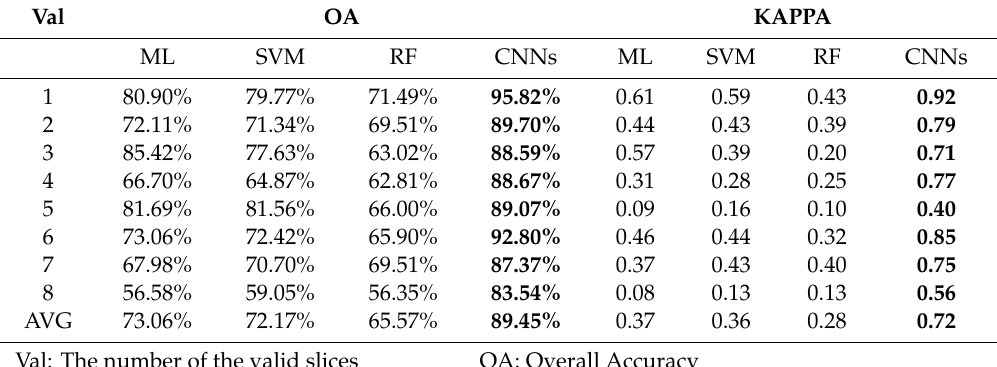
Table 5. Comparisons of Maximum Likelihood (ML), Support Vector Machine (SVM), Random Forest (RF), and Convolutional Neural Networks (CNNs) on pixel-wise classification. Val OA KAPPA ML